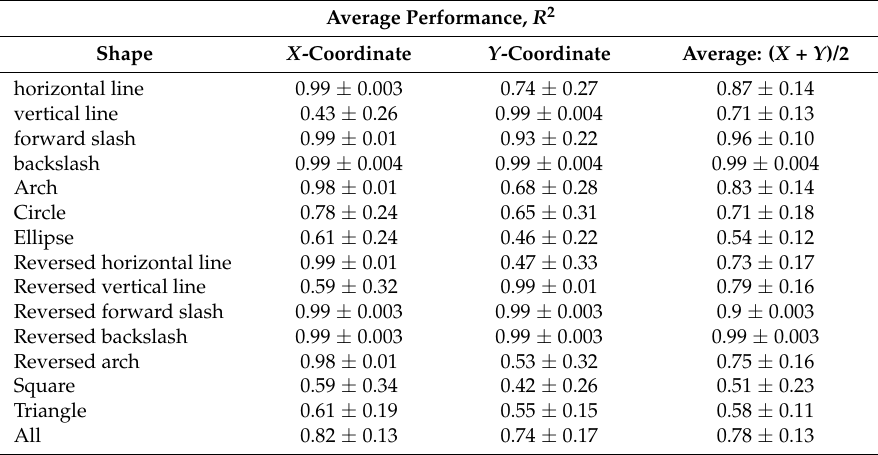
Figure 15. The randomly selected reconstructed drawing traces of between-group reconstruction by the GEP. Table 12. Between-group reconstruction performance by the GEP: the average accuracy of each shape across the five subjects.